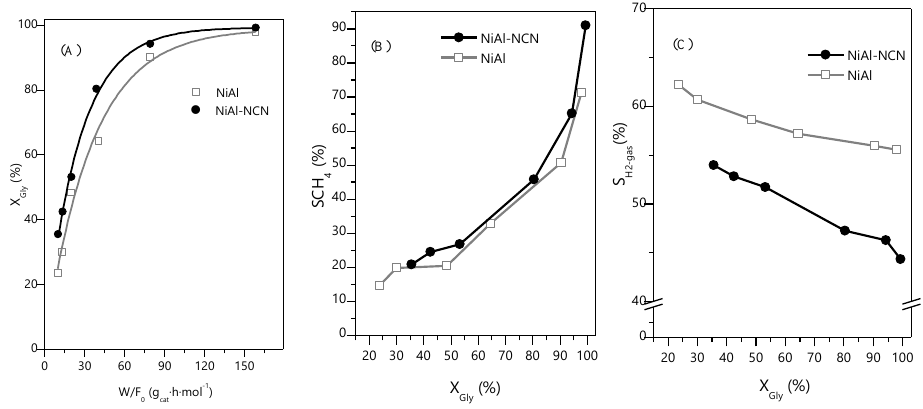
Figure 8. ( A ) Effect of the residence time on X Gly; ( B ) SCH 4 vs X Gly ; ( C ) S H2-Gas vs. X Gly .